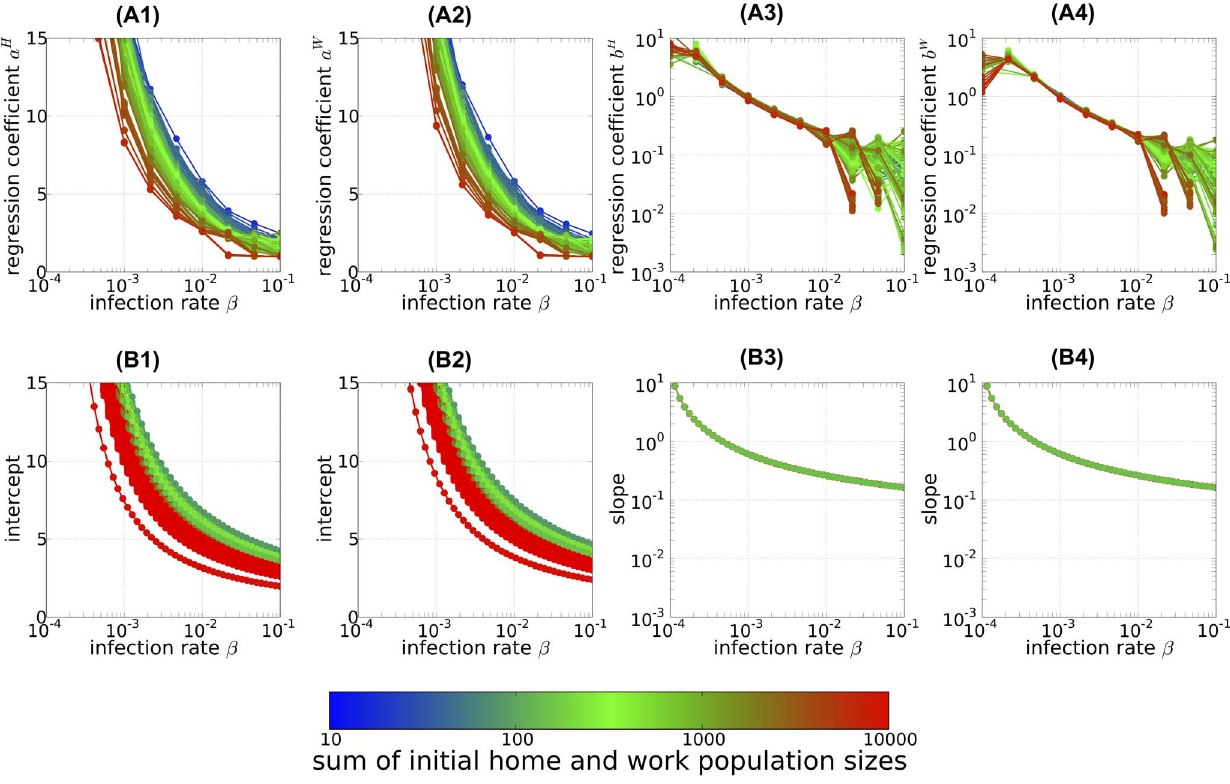
Figure 7. The intercept and slope of the linear relationship between the arriving time of epidemic and logarithmic local population size. The intercept (A1–2) and slope (A3–4) of linear regression line for the arrival time of epidemic, and the corresponding results calculated from the exponential growth approximation of the linearized population size class model (B1–2) and (B3–4), respectively (see main text for details of approximation) are shown. The results are plotted as the functions of infection rate and the color of each line indicates the sum of the population sizes of the initially infected home and work populations. (A1–4): regression coefficient statistically estimated from the results of the individual-based model (IBM) simulations. (A1) and (A2): estimated intercepts a H and a W , respectively. (A3) and (A4): estimated (sign reversed) slopes b H and b W , respectively. All regressions were statistically significant according to the P-value of the regression coefficient ( P v 0 : 001 ).